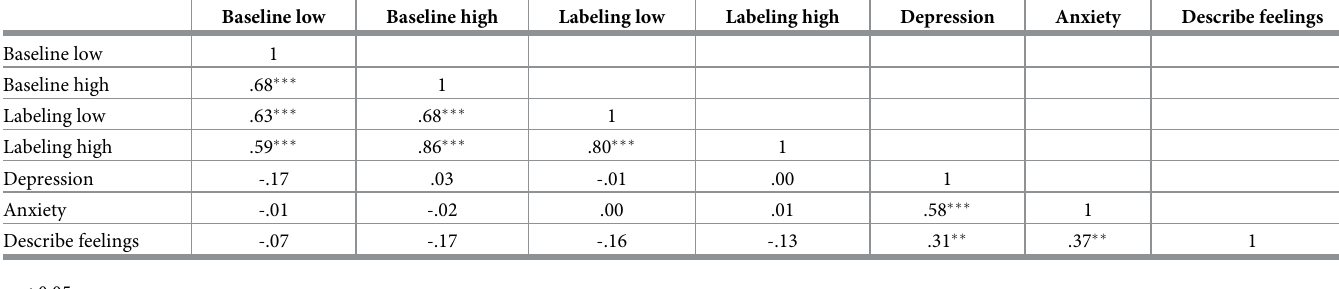
Table 3. Zero-order correlations between levels of distress in the different experimental conditions (baseline and affect-labeling), depression, anxiety, and difficulty in describing feelings. Baseline low Baseline high Labeling low Labeling high Depression Anxiety Describe